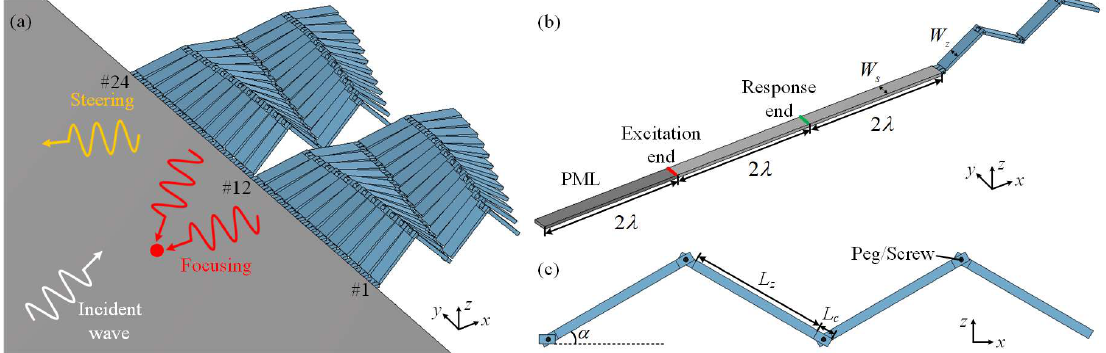
Figure 1. ( a ) Model of the tunable zig-zag reflective elastic metasurface. ( b ) Model of a subunit of the tunable zig-zag reflective elastic metasurface. ( c ) Enlarged view of the zig-zag structure with a folding angle α . # means the subunit